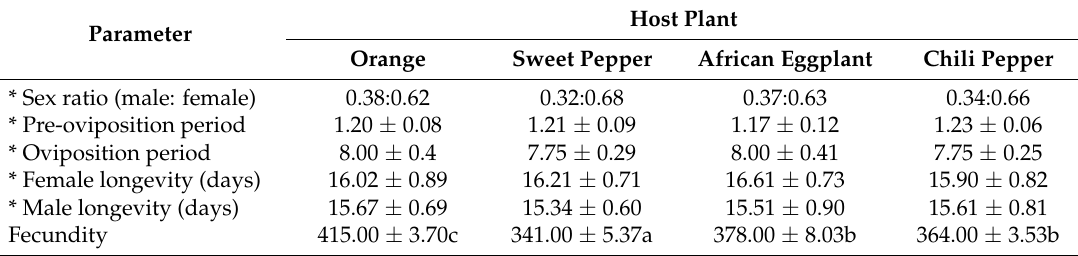
Table 4. Sex ratio, oviposition, female longevity, male longevity and fecundity of Thaumatotibia leucotreta reared on orange and solanaceous vegetables.